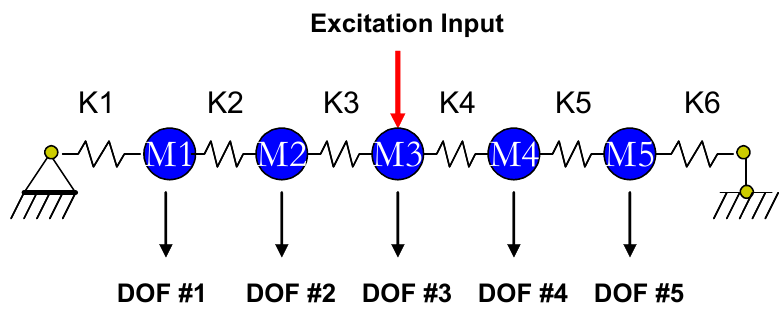
Figure 3. Idealized lumped-mass model for the steel bridge